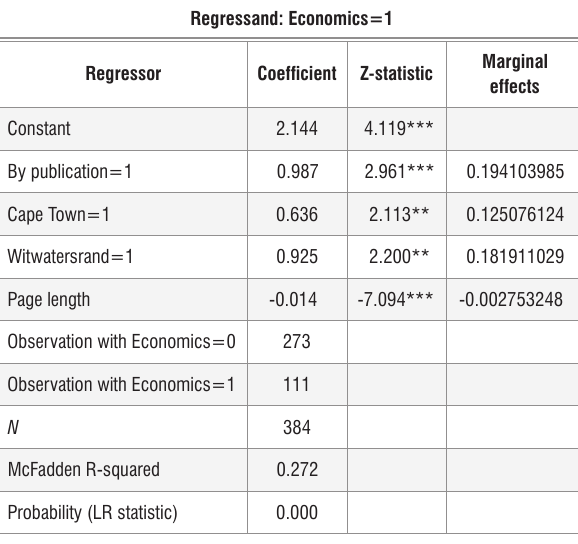
Final logit regression model that distinguishes between economics PhDs and PhDs produced in the rest of the